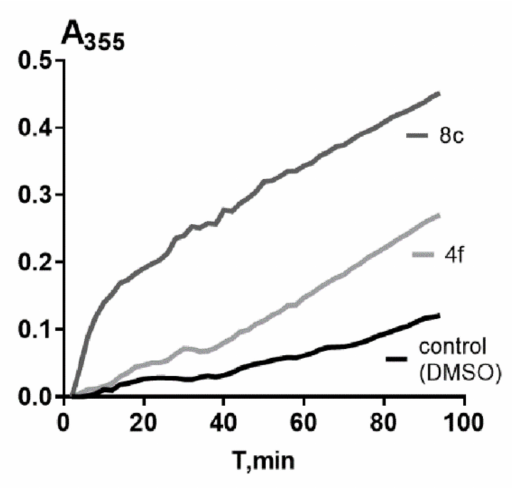
Figure 7. Representative curves of effect of compounds 8c and 4f on GTP-dependent Tb+MAP